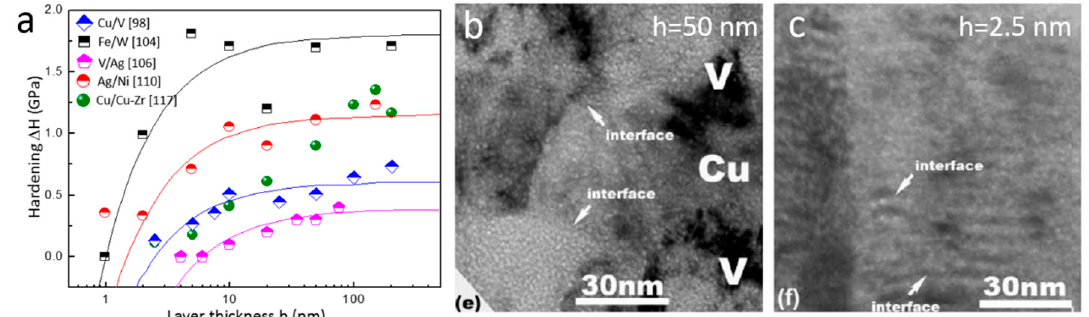
Figure 17. ( a ) Size dependent radiation hardening in various multilayers [98,104,106,110,117]; ( b ) TEM images of He irradiated Cu/V with a layer thickness of 50 nm [100]; and ( c ) He irradiated 2.5 nm Cu/V multilayers [100]. Reprinted with permission from [100]; Copyright 2009 Elsevier.